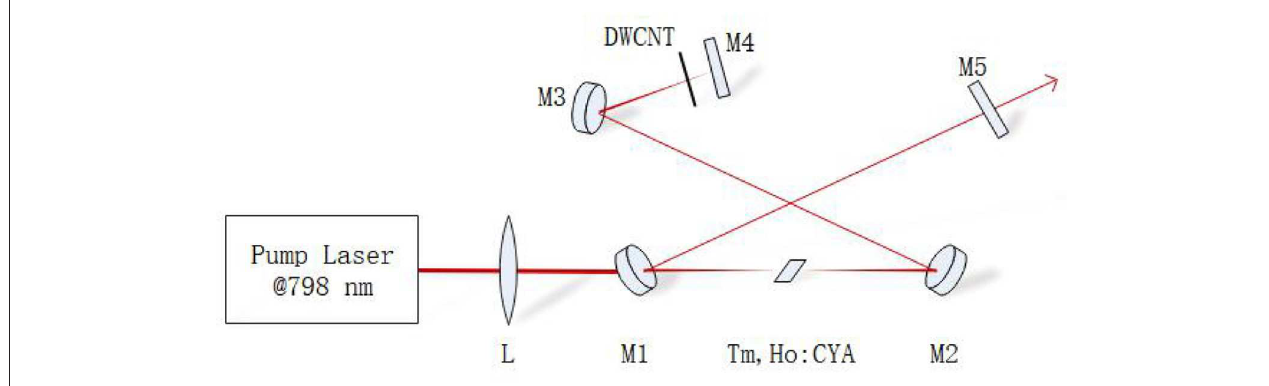
FIGURE 1 | The experimental setup of Tm,Ho:CaYAlO 4 passively QML laser